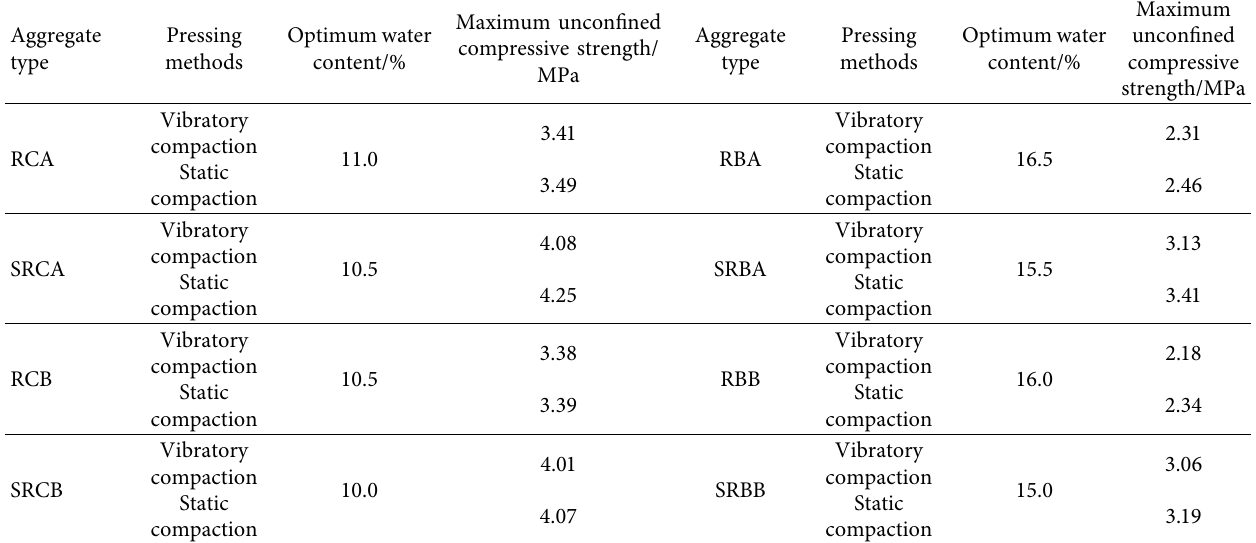
Table 3: Unconfined compressive strength test results.